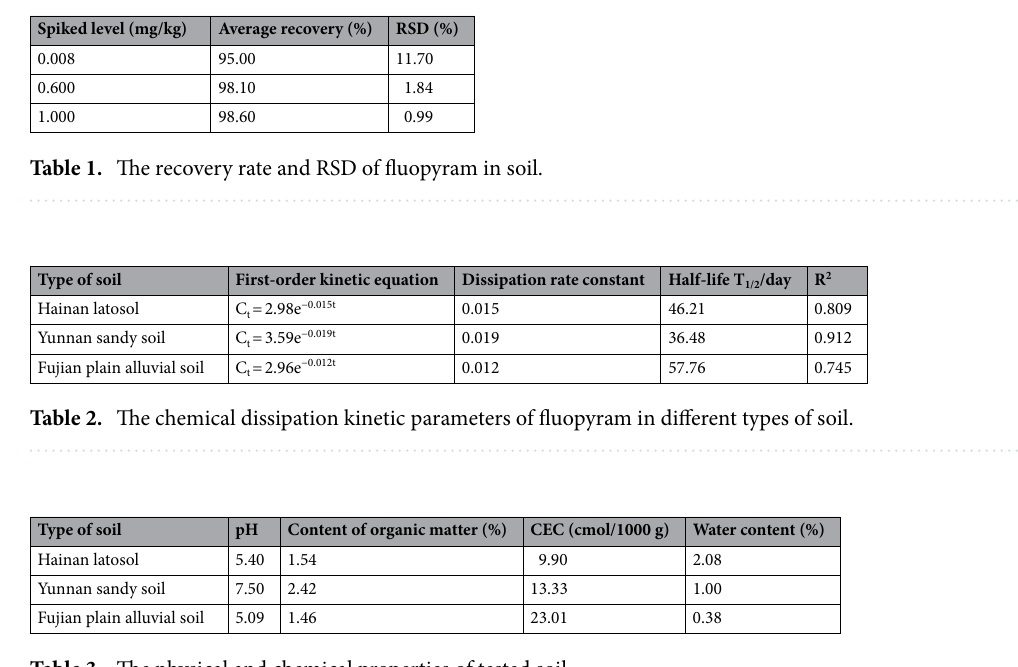
Table 3. The physical and chemical properties of tested soil.